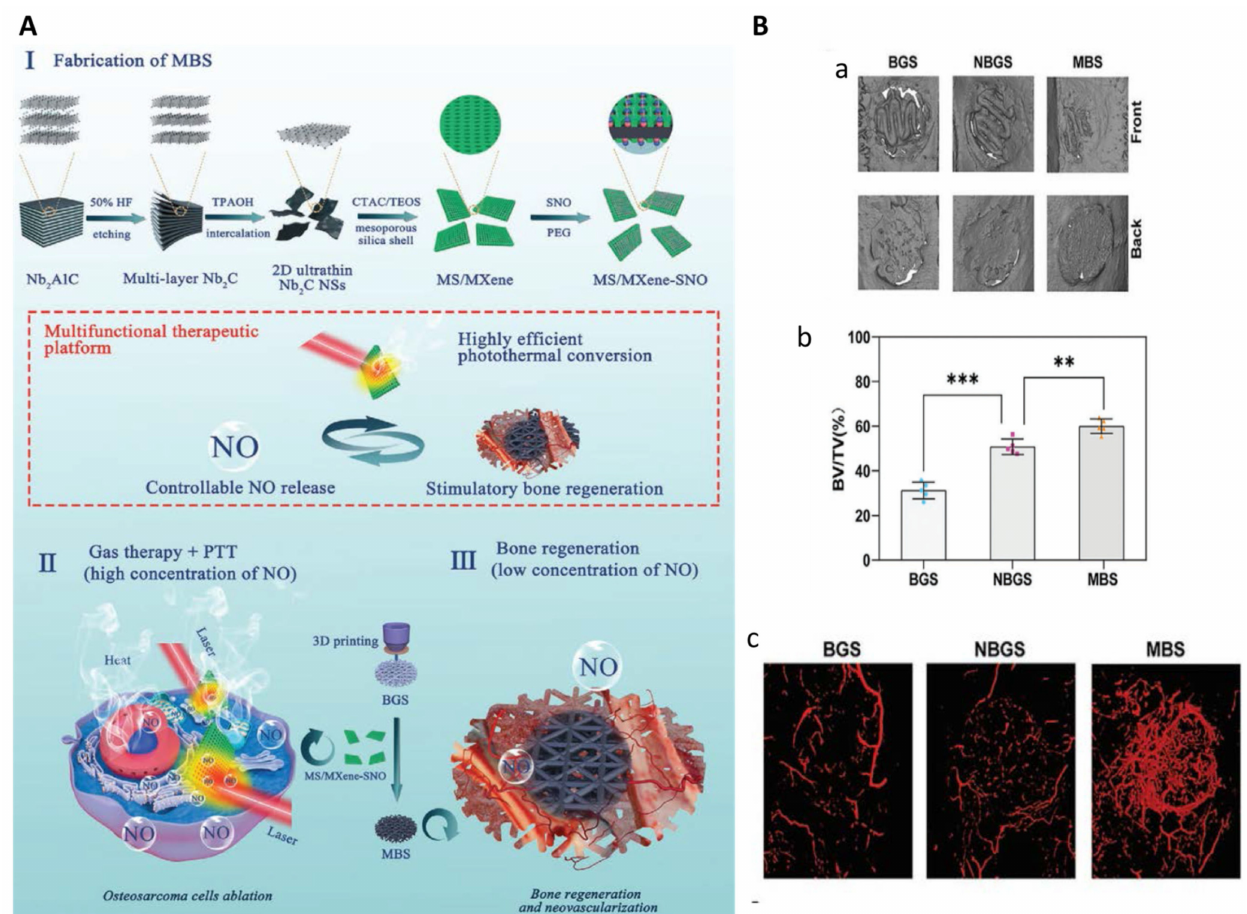
Figure 6. ( A ) Schematic illustration of the multifunctional therapeutic platform. ( B ) In vivo combinatory performance of bone formation and neovascularization. ( a , c ) 3D reconstruction of cranial defects and vessels at week 16 after implantation. ( b ) Quantitative fundamental parameters of bone volume/tissue volume (BV/TV) in newborn osseous tissue. ** p < 0.01 and *** p < 0.001. Reproduced from ref. [291] with permission from Wiley Online Library. Copyright (2020)